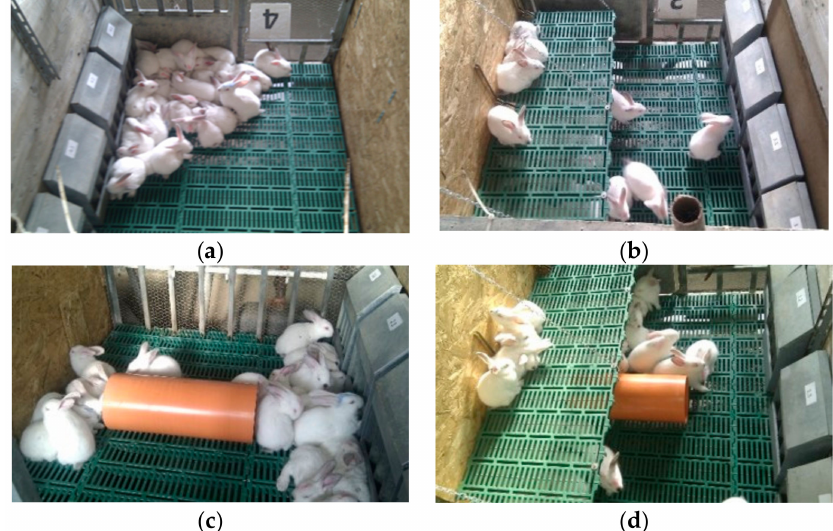
Figure 1. Photographs of pens used to evaluate enrichment with platforms and tubes: ( a ) pens without enrichment; ( b ) pens with platform; ( c ) pens with tube; ( d ) pen with platform and